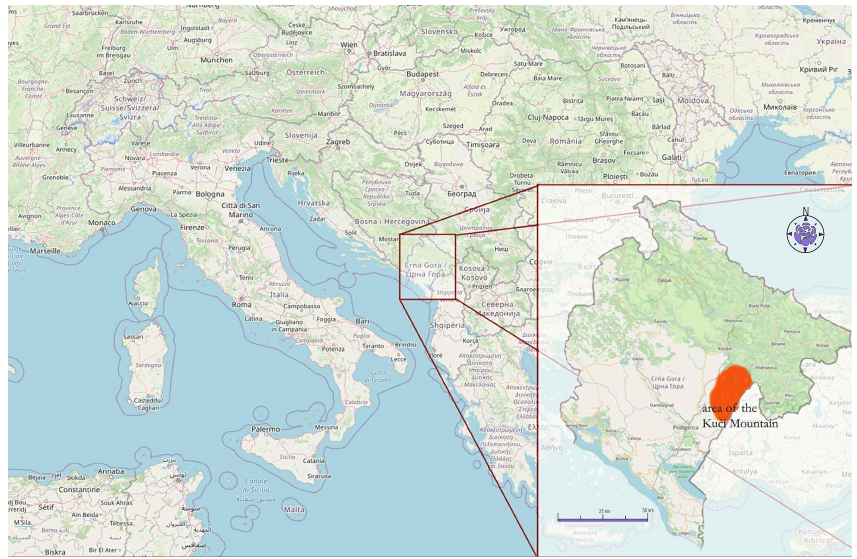
Figure 1. Map of the case study